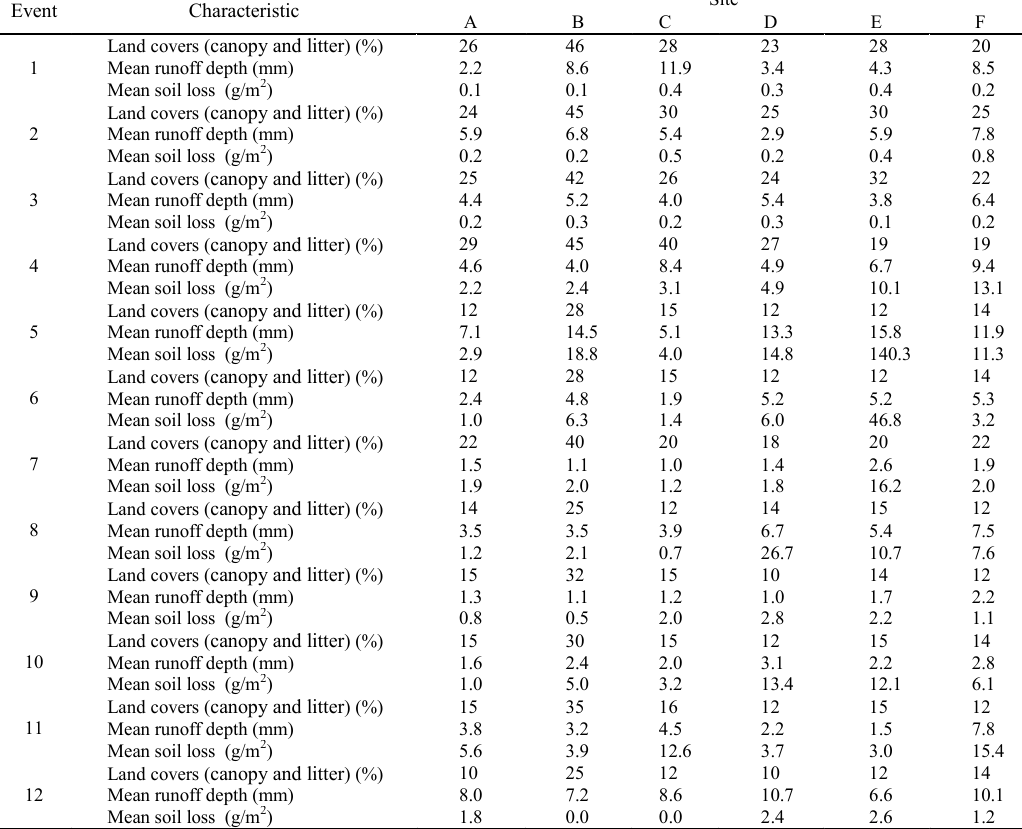
Table 4: Mean data obtained from each site for rainfall events